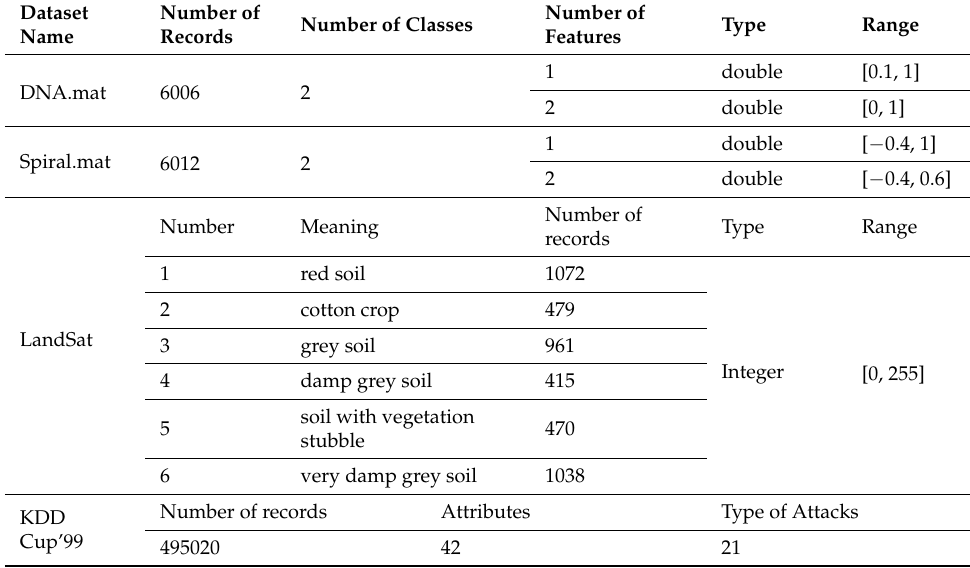
Table 2. Datasets